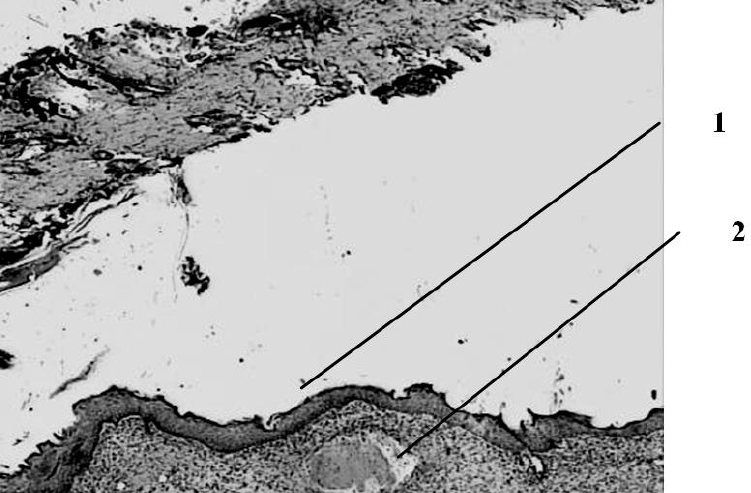
Figure 8. The scab is separated from the wound on most of the surface in rats treated with ozone–oxygen mixture (1 — the wound is covered with a layer of regenerated epidermis; 2 — young scar tissue is visible under the epidermis). magn. ×50.